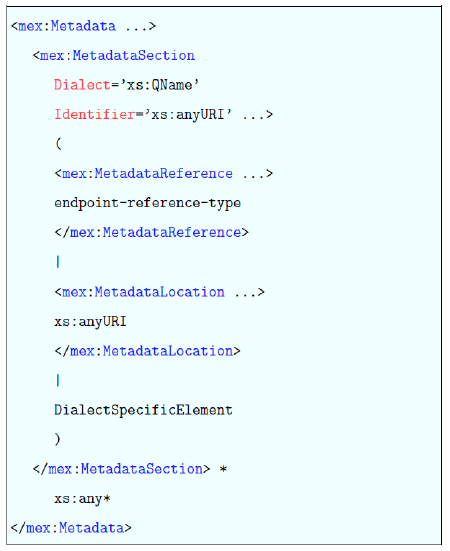
Figure 1. The general structure of the <Metadata> Element.